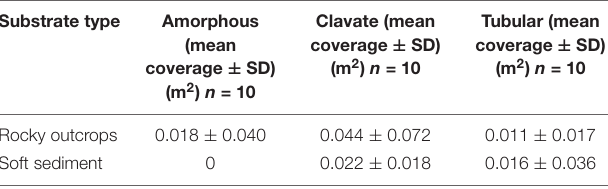
TABLE 8 | Taxonomic richness by OMZ strata and its dissolved oxygen concentration range. Phylum Lower boundary of the OMZ core